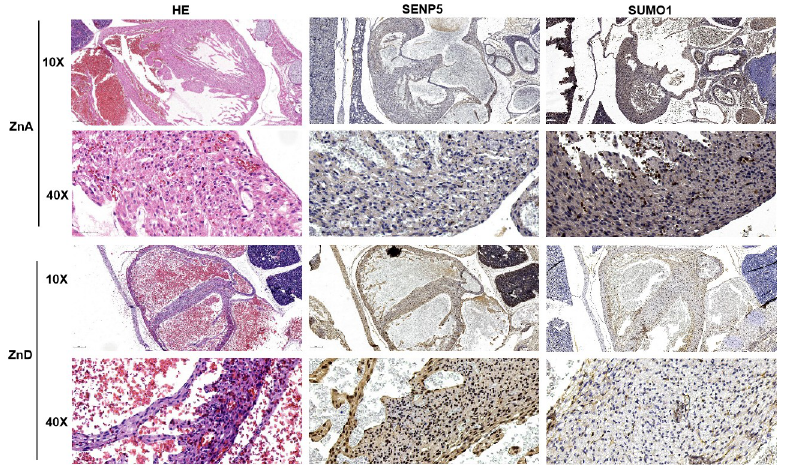
Fig 4. Difference in development of the myocardium and characteristics of SENP5 and SUMO1-modified proteins between zinc deficiency and control groups during fetal mouse development. HE staining and immunohistochemistry of SENP5 and SUMO1-modified proteins at E15.5 in zinc-deficient and control groups are shown (n = 3).